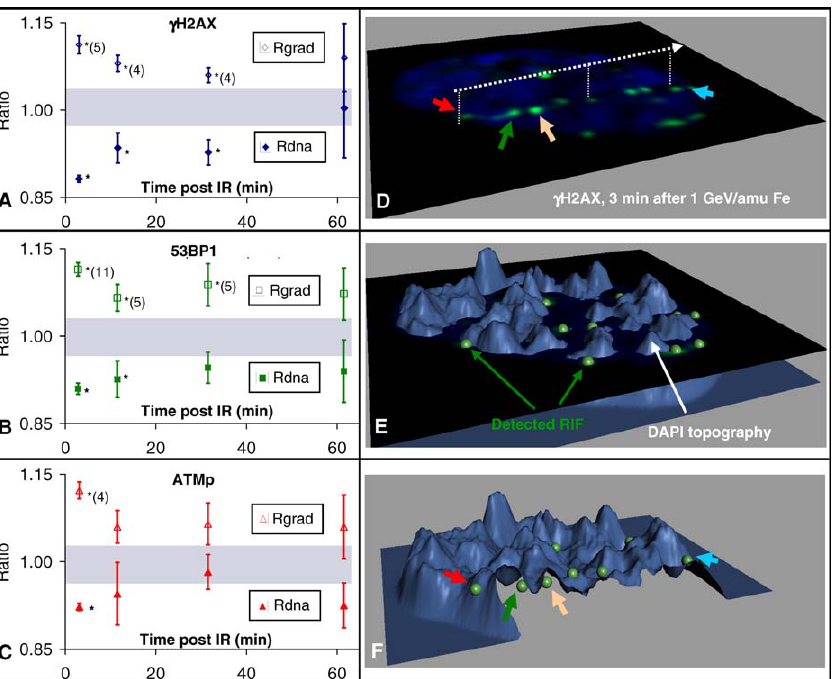
Figure 7. Rdna and Rgrad Computation Confirm Rapid Relocation to Dim–Bright Nuclear Interfaces with a Lower Proportion of Foci in the High DNA Density Regions after Exposure to 1 Gy of 1 GeV/amu Fe Measured Rdna and Rgrad normalized to predicted values are graphed in (A–C). For all DNA damage markers analyzed here, all Rgrad ratios are above 1 and Rdna ratios are below one. This indicates a tendency of RIF to locate themselves at the interface between high and low DNA density regions and preferably in the low DNA density regions. This tendency is stronger within the first 10 min following exposure to radiation and statistically significant for c H2AX and 53BP1 for the first 30 min post-IR (significance is labeled by an asterisk with the number of independent experiments in parentheses, statistical test based on t- test between measured averages and predicted ones. Predictions are based on reshuffling original RIF. Based on that test, a 95% confidence interval for expected normalized ratios is shown as the gray area). For ATMp, only the earliest time point was statistically significant, indicating a return to normality much faster than the other markers. A representative nucleus 3 min post-IR is shown in (D), with c H2AX RIF appearing as a green signal and DAPI shown as blue. The white dashed arrow indicates the traversal of one Fe particle, and small solid-color arrows indicate specific RIF. The same nucleus is seen in (E) with the DAPI intensity displayed in a 3-D topographic blue surface and segmented c H2AX RIF shown as green beads. (Rendering done with Bitplane, http://www.bitplane.com/). (F) shows the same topographic view, sectioned along the particle trajectory to better appreciate the position of RIF with respect to the DAPI intensity profile. For orientation purposes, the same RIF shown with solid color arrows in (D) are shown in (E) and clearly illustrate the preferred location of RIF at the interface between high and low DNA density